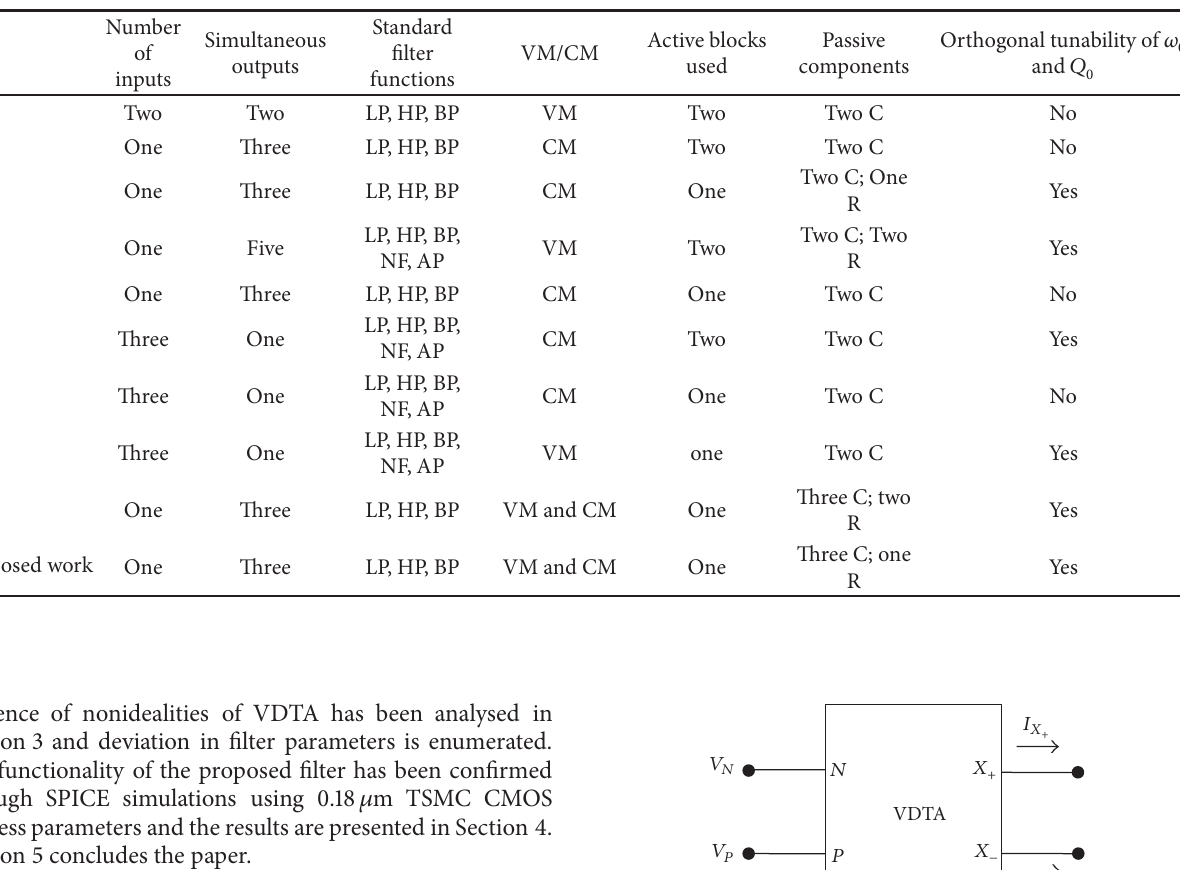
Table 1: Comparison of the proposed work with the previously reported work.